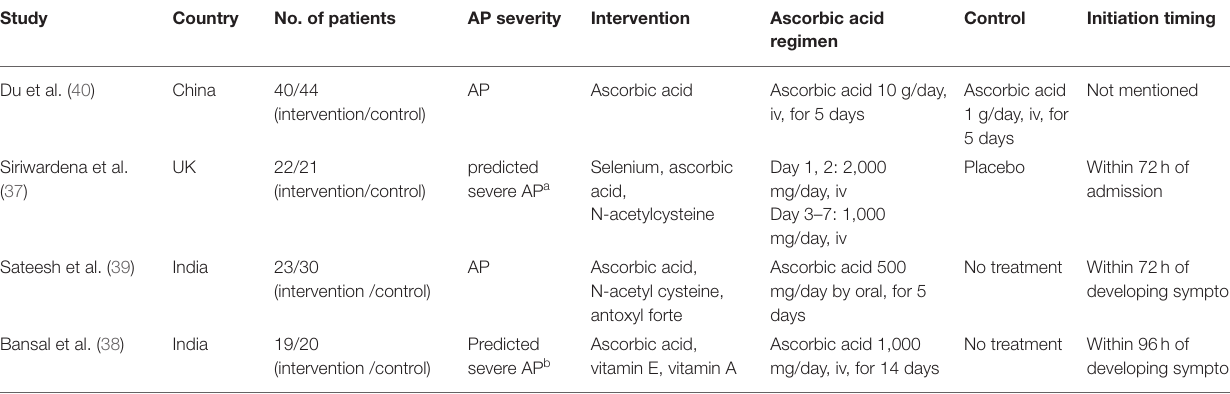
TABLE 1 | Characteristics of clinical trials included in the meta-analysis. Study